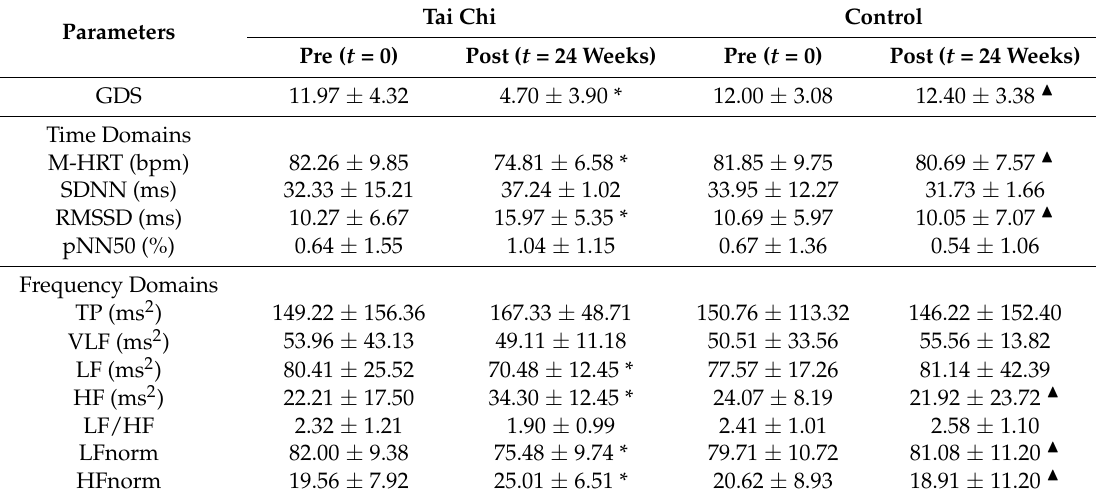
Table 2. Effects of Tai Chi on depression and heart rate variability.